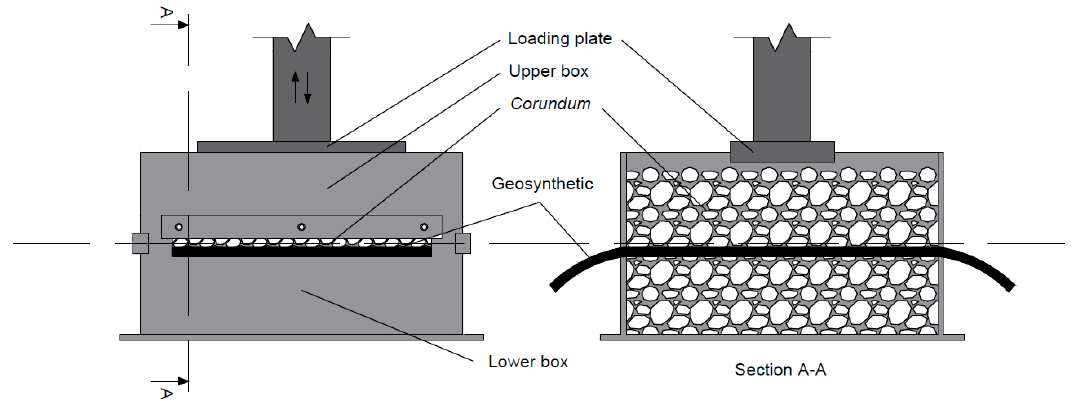
Figure 1. Schematic representation of the equipment for mechanical damage under repeated loading tests.